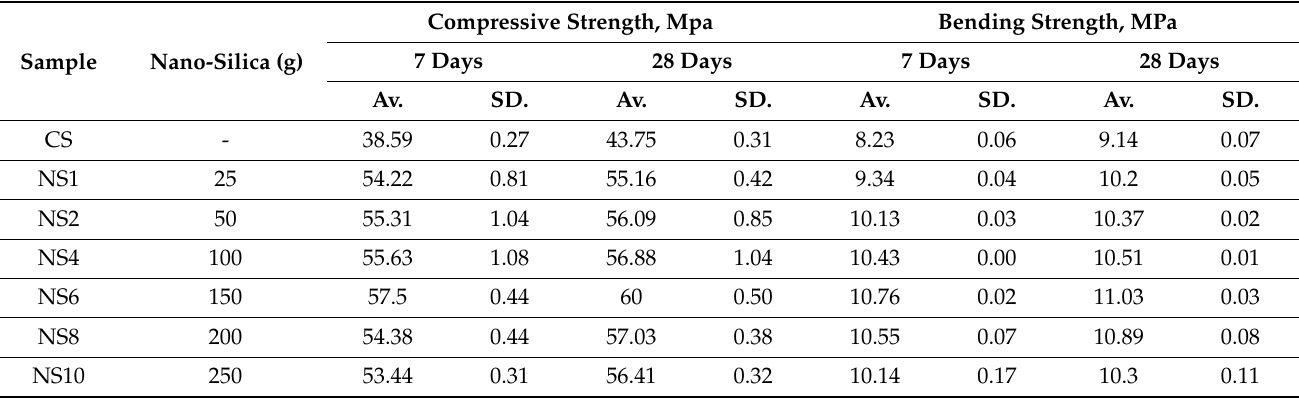
Table 6. Compressive and bending strengths of mortar containing nano-silica.